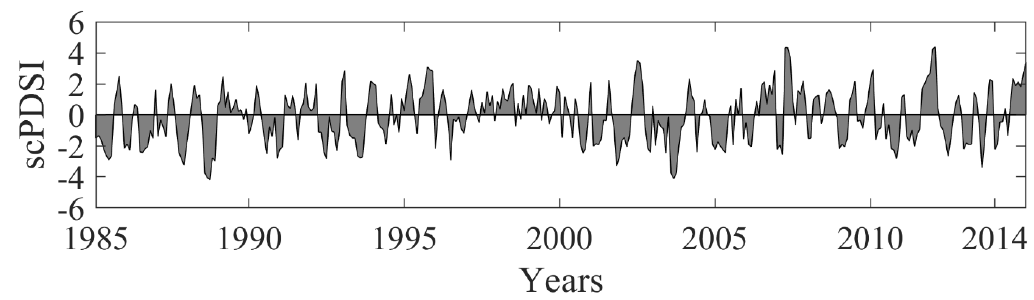
Figure 12. Drought duration maps for historic observed data for study area AV. ( a ) For severe drought and ( b ) for extreme drought. The scale bar represents months of drought in historic 30 years (1985 – 2014).